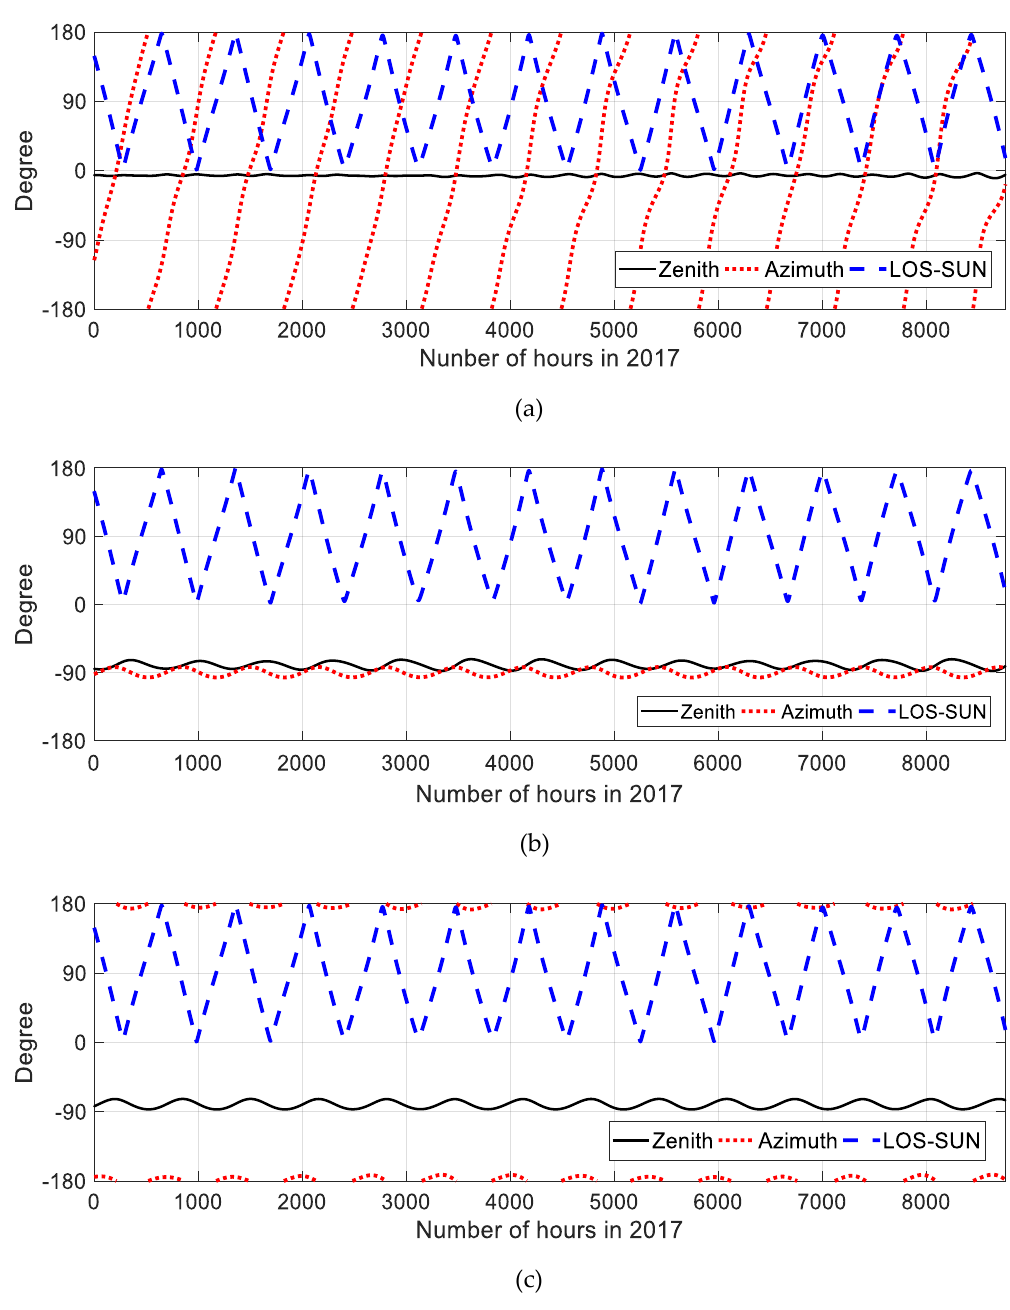
Figure 10. Attitude of the sensor.